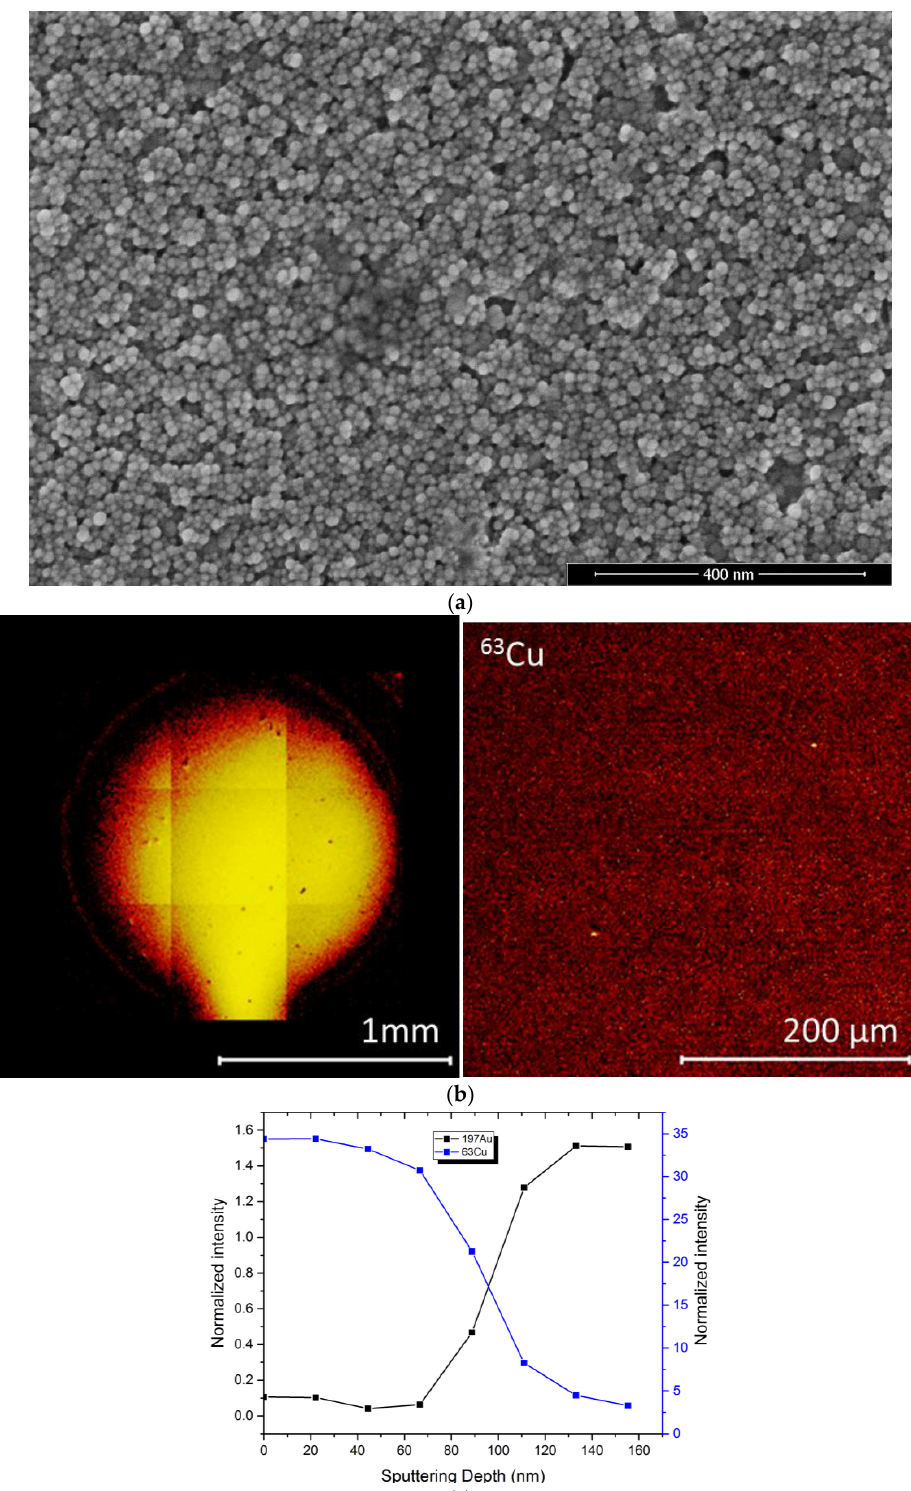
Figure 2. ( a ) SEM nanoparticle structure of cuprous oxide film; ( b ) TOF-SIMS evaluation of the homogeneity of the sensor’s surface; ( c ) Depth profile for the thickness of the cuprous oxide film.